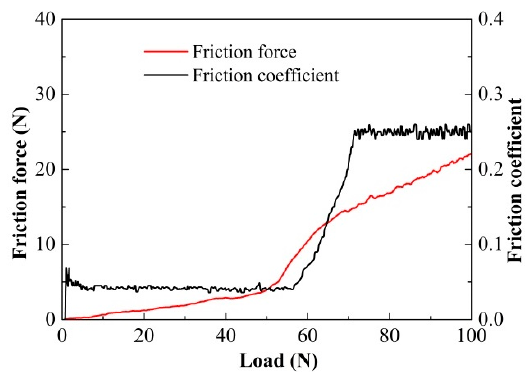
Figure 7. Adhesive force curve in scratch test with the Zr current of 30 A.